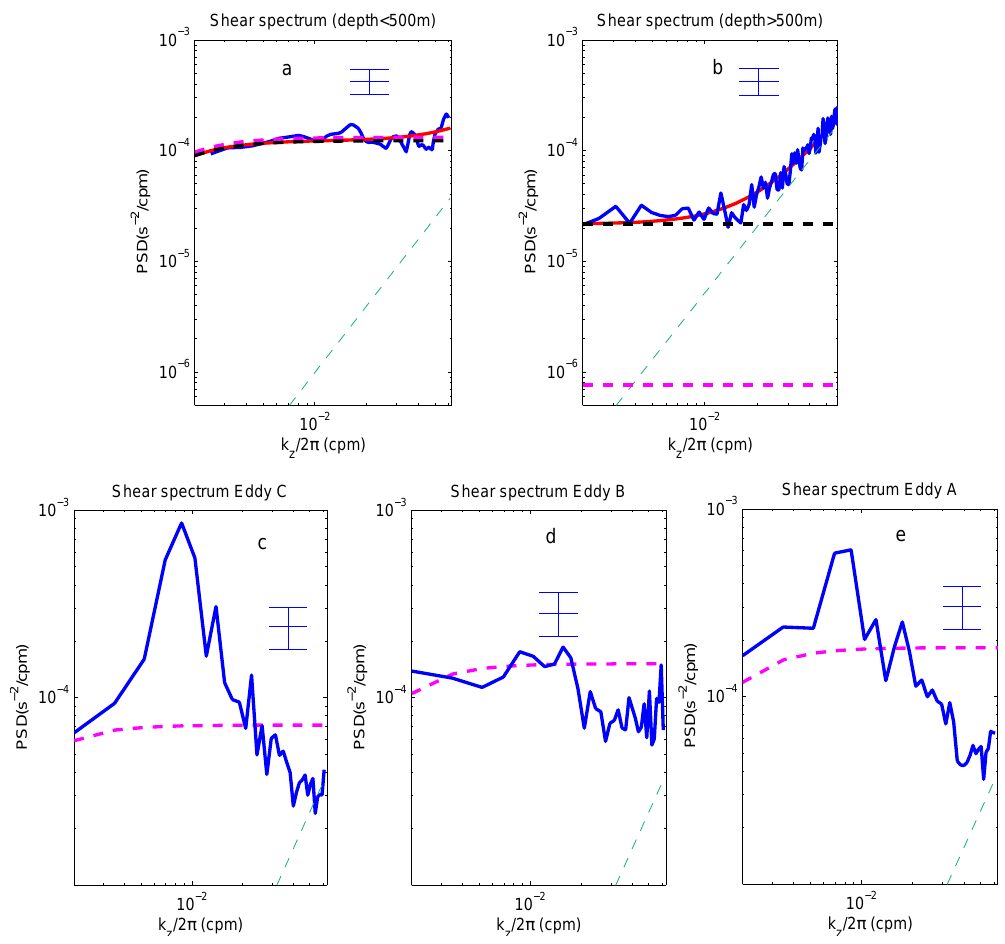
Fig. 2. Upper row: wavenumber vertical shear spectrum for deep SD stations LADCP profiles (a) 0 < z < 500m, (b) z > 500m and lower row ensemble averaged wavenumber vertical shear spectra for LD stations LADCP profiles at (c) eddy C, (d) eddy B and (e) eddy A. In blue, raw data vertical shear spectrum; in magenta dashed line, GM level shear spectrum; in black dashed line, the fitted GM shear spectrum; in cyan dashed line, the noise fitted spectrum; and in red, the composite of noise and GM fitted spectra. The vertical bars indicate the 95% confidence intervals. For spectra in eddies ( c , d , e ), no fit was performed and the noise spectrum is assumed to be identical to the one in (a) (see text)